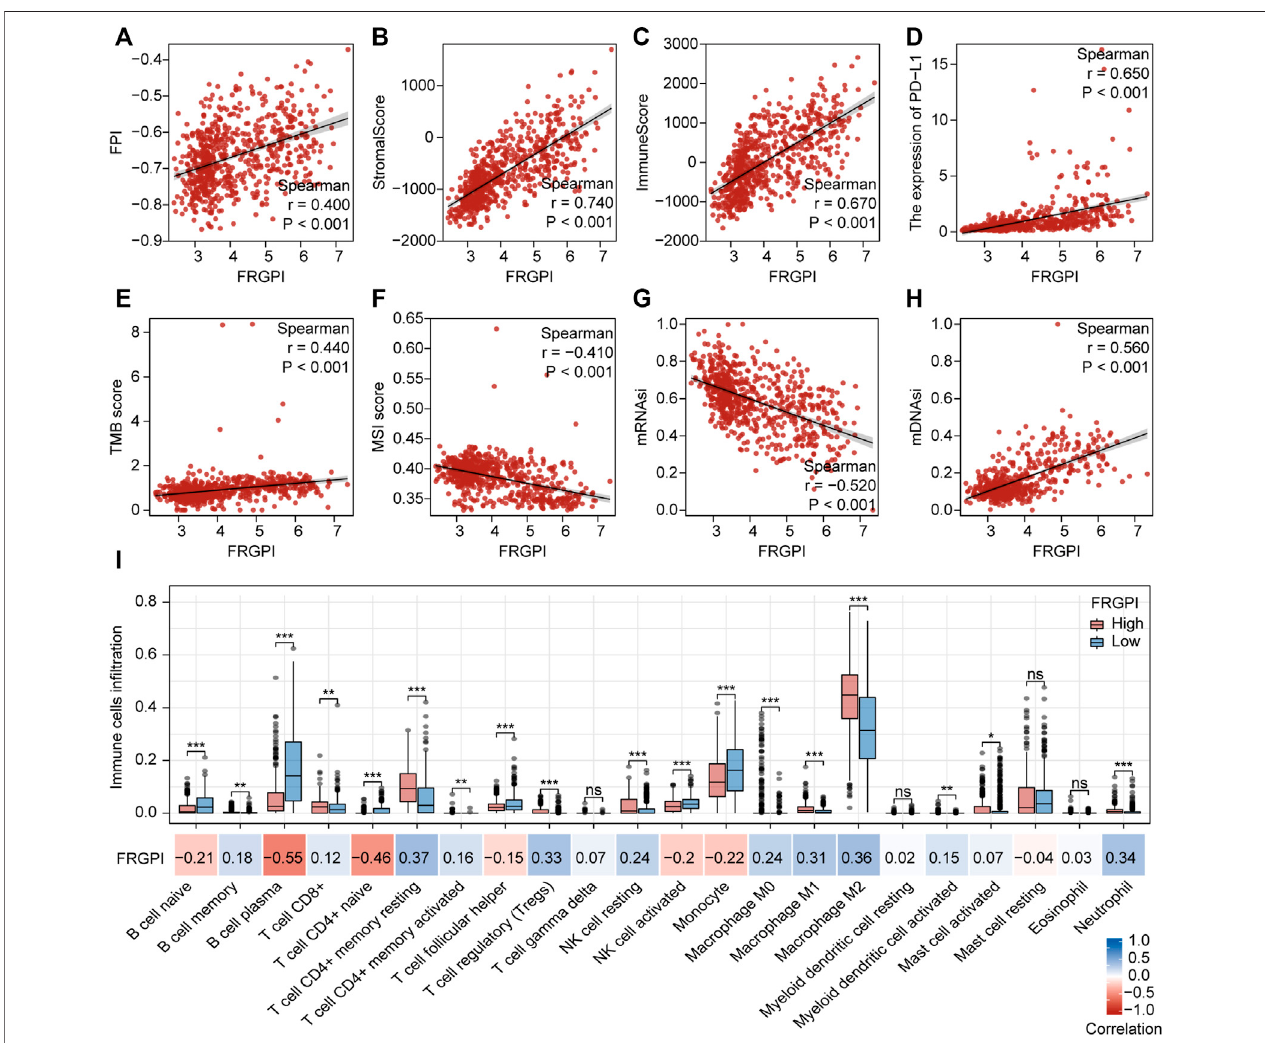
FIGURE8| Anti-tumorimmunityandintrinsic immune escape associated withFRGPI.Spearmancorrelation coef fi cients andassociated p -valueofFRGPI with (A) FPI, (B) stromalScore, (C) immuneScore, (D) the expression of PD-L1 , (E) TMB score, (F) MSI score, (G) mRNAsi, (H) mDNAsi are shown. r, Spearman coef fi cient; ns, no signi fi cance; * p < 0.05; ** p < 0.01; *** p < 0.001. (I) Different immune cell in fi ltration between high and low FRGPI group, and the correlation between FRGPI and immune cells in fi ltration. ns, no signi fi cance; * p < 0.05; ** p < 0.01; *** p < 0.001; blue, positive correlation; red, negative correlation.